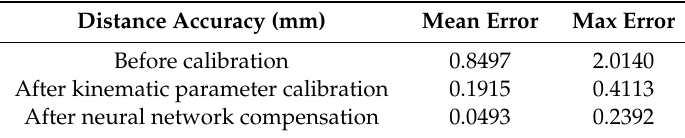
Table 4. Distance accuracy of the